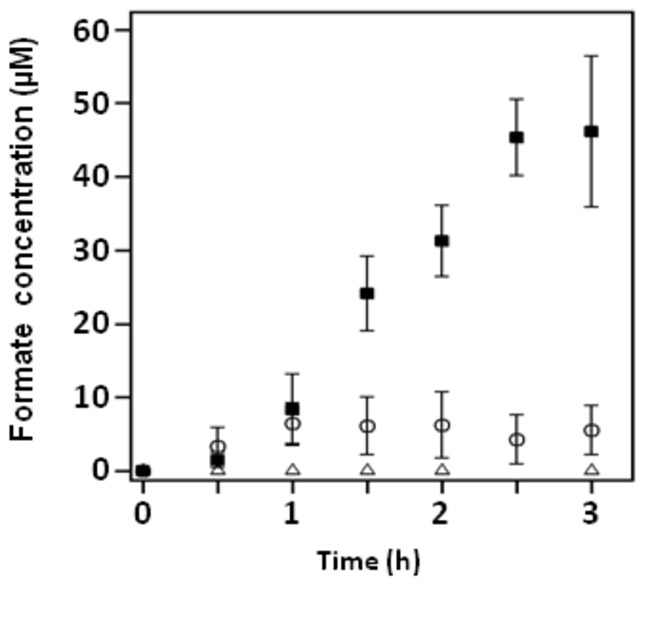

In vitro light-driven CO2 fixation by PS I and NADPH-FDH.The reaction solutions contained PS I (100 µg chlorophyll/mL), 10 mM ascorbate, 10 µM PC, 2 µM Fd, 0.5 µM FNR, 1 mM NADP+, and 4 mM NADPH, 2.5 mg/mL (~56 µM) PsFDH(QN), 0.05% Triton X-100 and 10% sucrose in PBS. The solution were degassed and then charging with 100% CO2 for 1 min. The reaction was initiated by illuminating with visible light (<420 nm) at an intensity of 1000 µmol photon m-2 s-1, and monitored by sampling at regular intervals without exposure to O2 (closed square). The control reactions were performed without the illumination (open circles) and in the presence of 10% oxygen gas (open triangles).